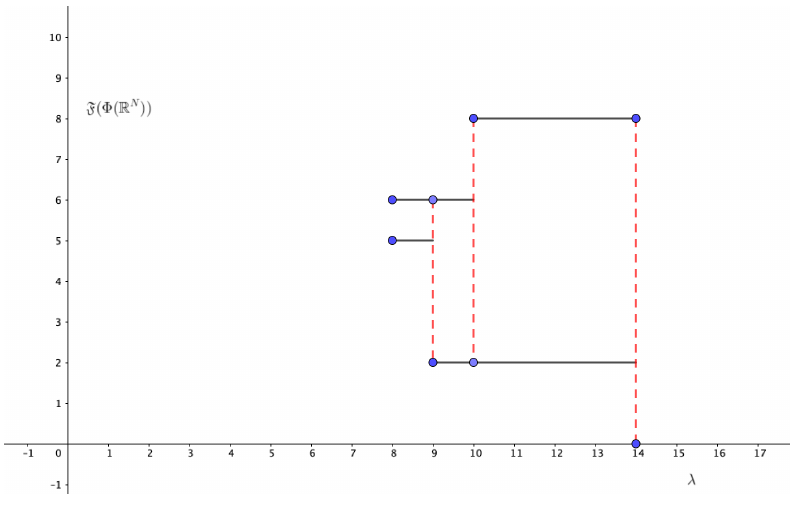
Figure 7. The map λ (cid:55)→ LS λ ( f X ) for X = ( 11,14,9,7,9,7,8,10,9 )